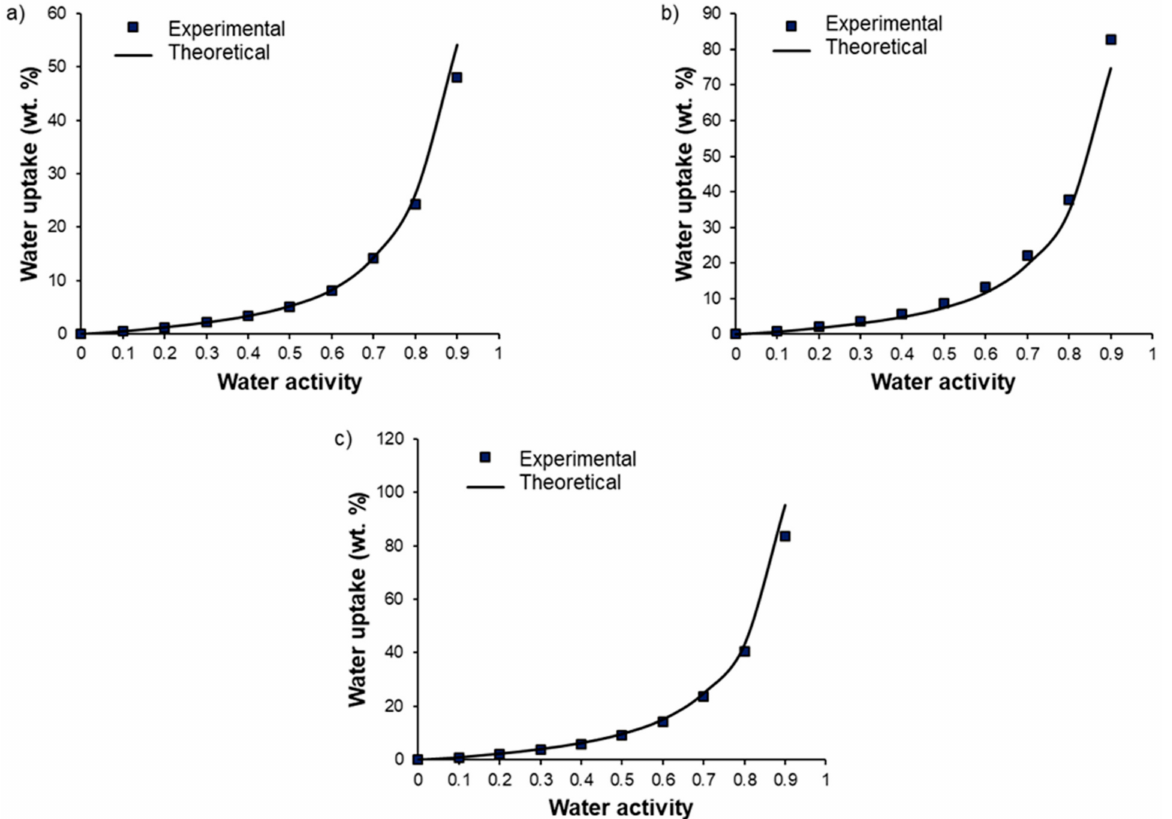
Figure 10. Comparison between experimental water uptake values and theoretical water uptake values calculated by an additive model as a function of water activity for Pebax ® /PEG OH blends with a PEG OH amount of 10 wt.% ( a ), 30 wt.% ( b ), and 50 wt.% ( c ).